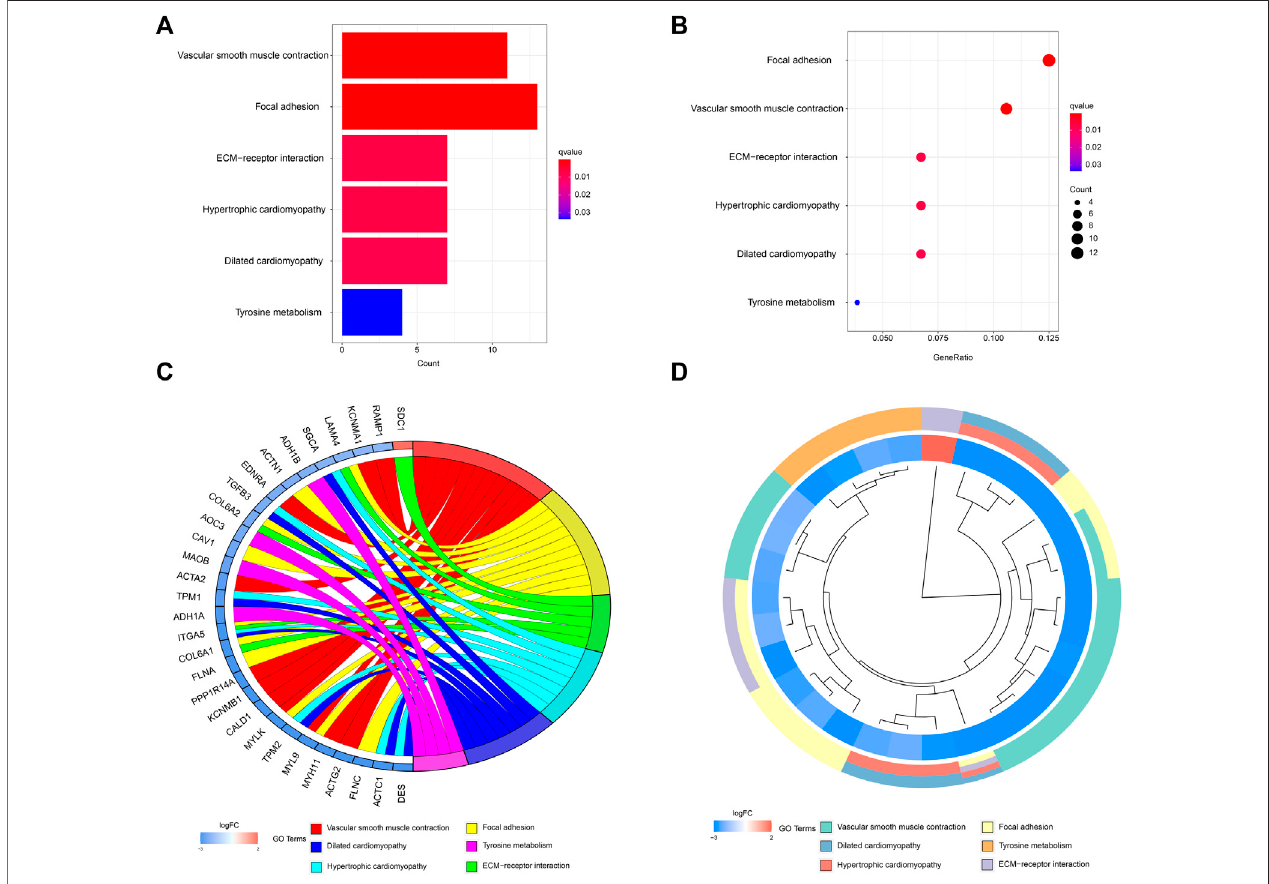
FIGURE 4 | (A,B) Detailed information relating to changes in the functional pathways in the control and treatment group through KEGG pathway analysis. (C,D) characteristic changes in up- and downregulated DEGs and their relationships with different functional